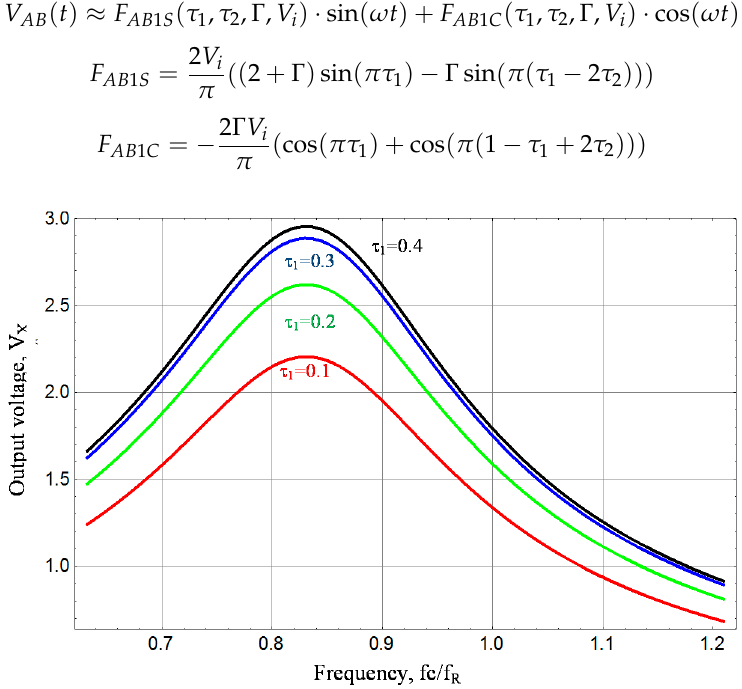
Figure 7. Output voltage versus frequency for τ 2 = 0.2 and R = 1.